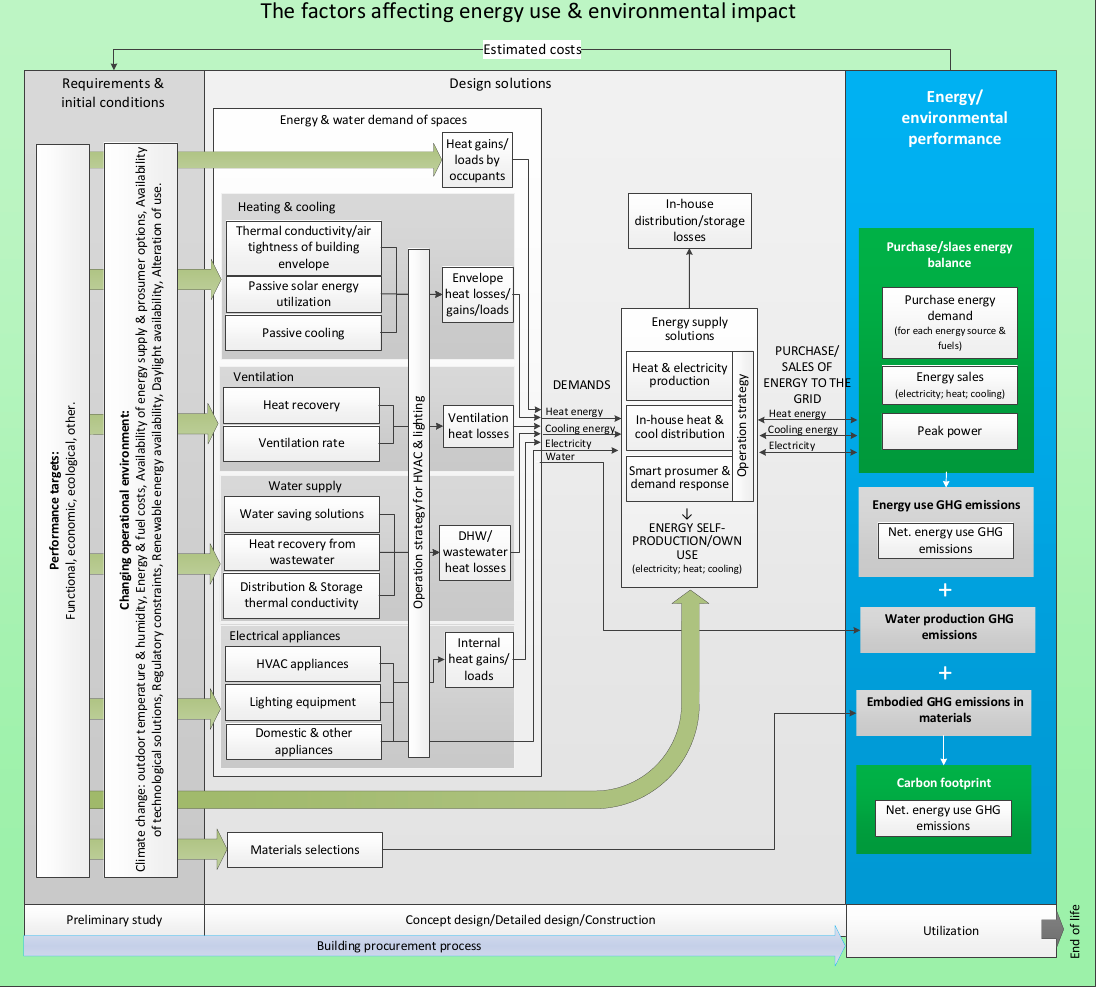
Figure 4. The identification of the factors affecting energy efficiency and the environmental impact of a building.